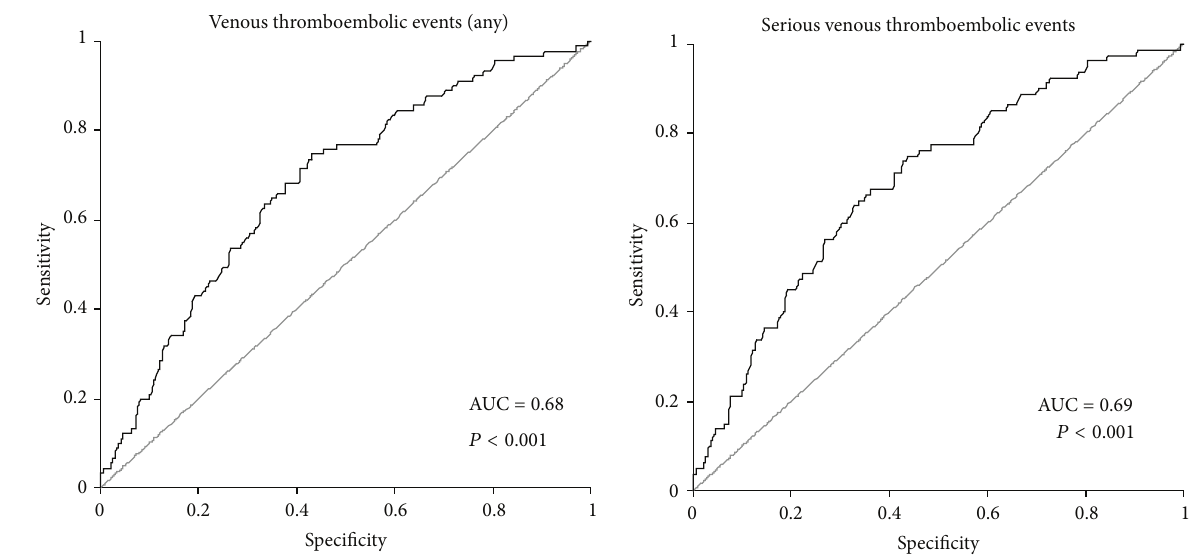
Figure 2: ROC analysis of the relationship between platelets and thromboembolic